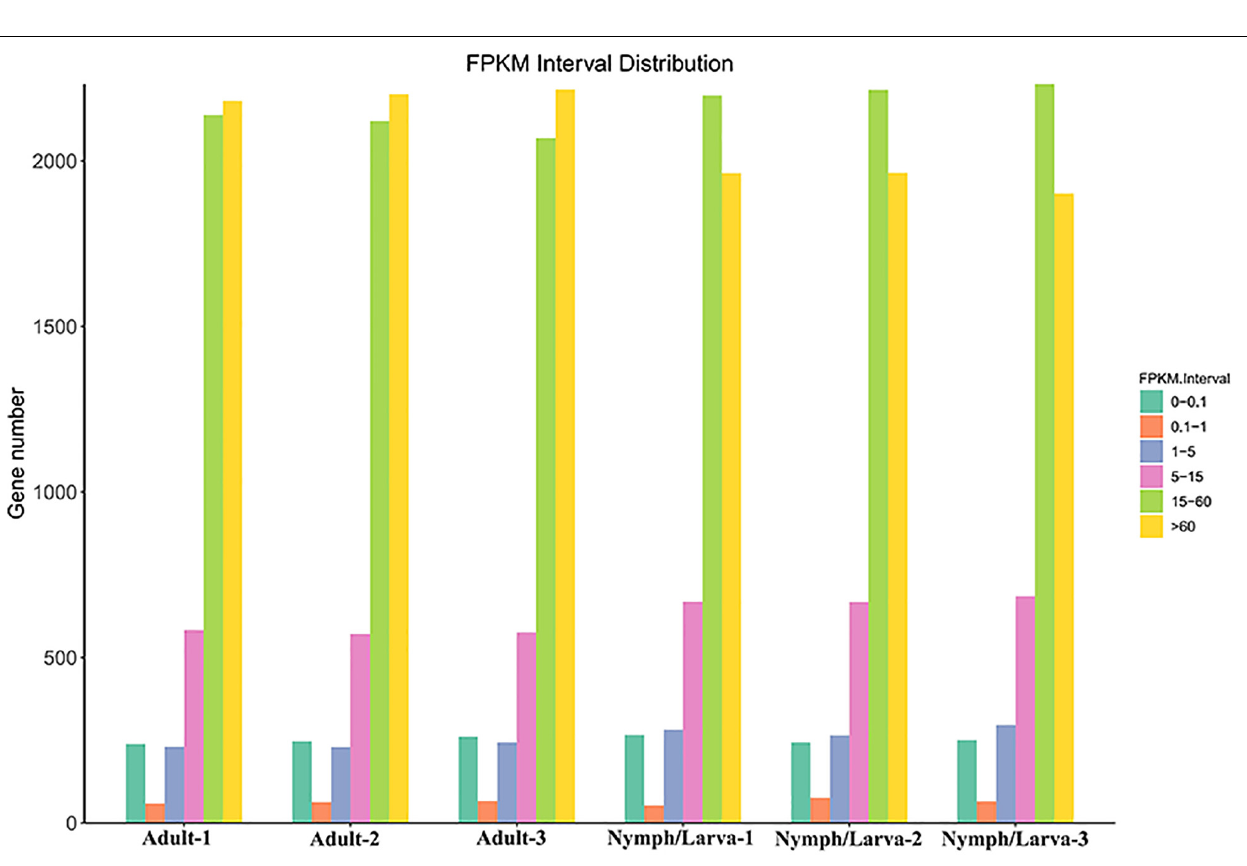
Frontiers in Microbiology |